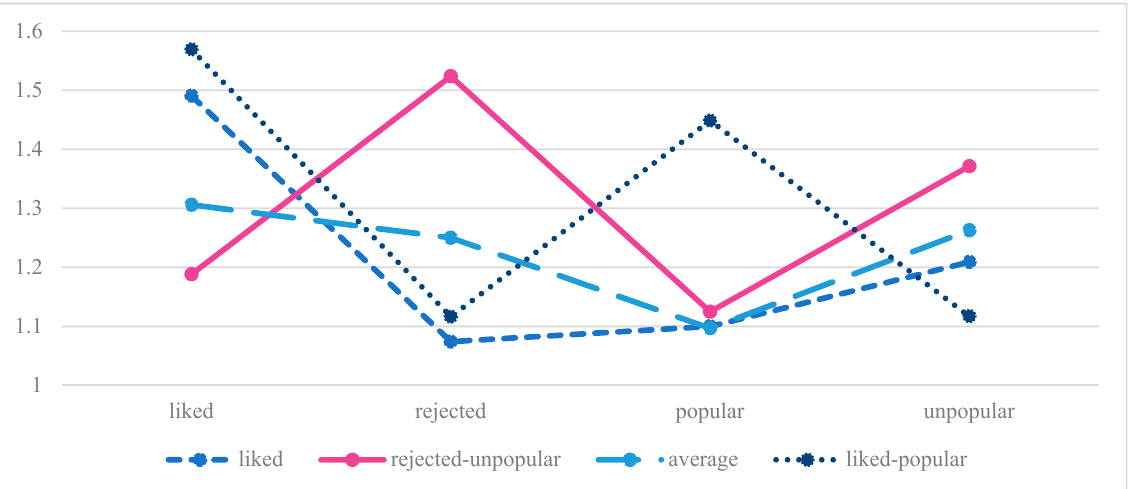
Figure 2. Four profile solution, no abuse group.